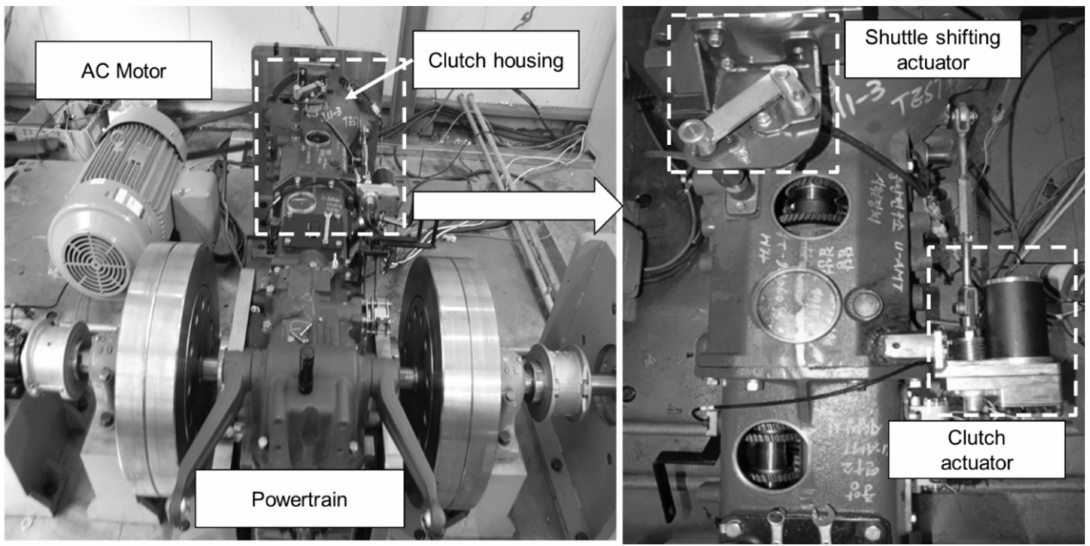
Figure 9. Experimental test-bed for AMT performance